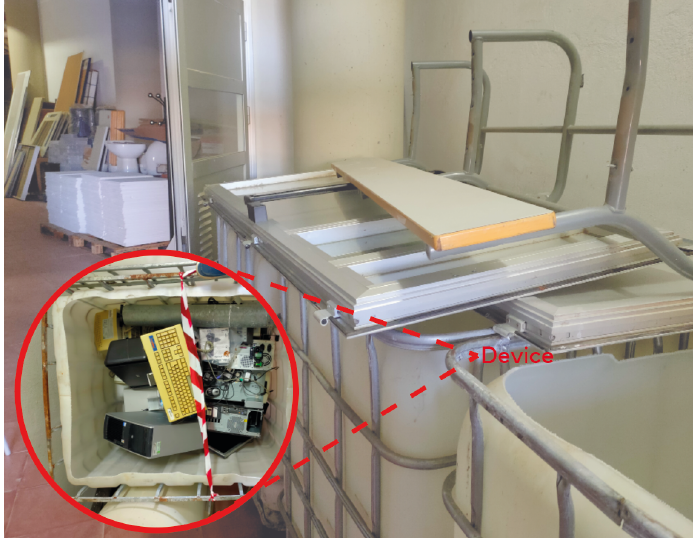
Figure 2. Image of the scenario. Figure 3 represents the map of the scenario where the UWB (green) and WiFi APs (orange) are placed and the distance to the device under rubble is given. The distance from the UWB (UWB1, UWB2, UWB3, and UWB4) and the WiFi (WiFi1, WiFi2, WiFi3) reference points is indicated next to the dashed line. To clarify the schema, vertical and horizontal views are provided for a better comprehension of the